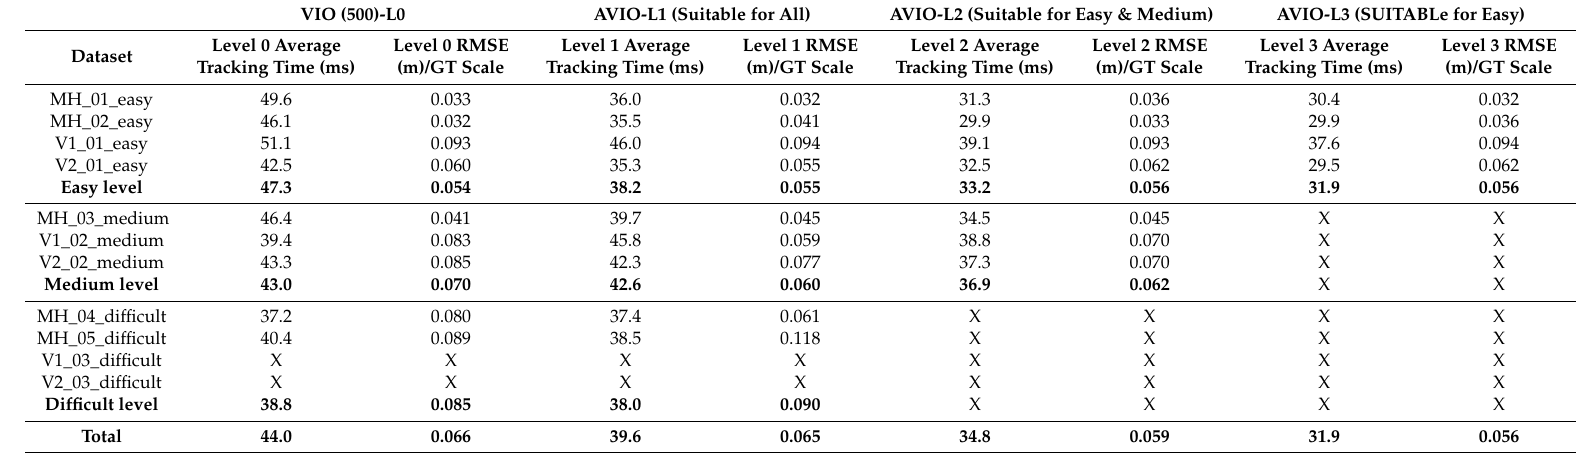
Table 8. Evaluation of AVIO-based SLAM in a single-core single-threaded